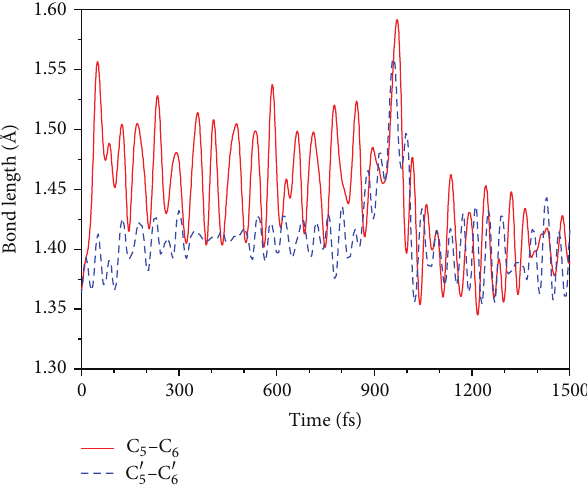
Figure 5: The variations with time of the lengths between the C 5 and C 6 atoms and the C 󸀠 5 and C 󸀠 6 atoms in two stacked cytosine